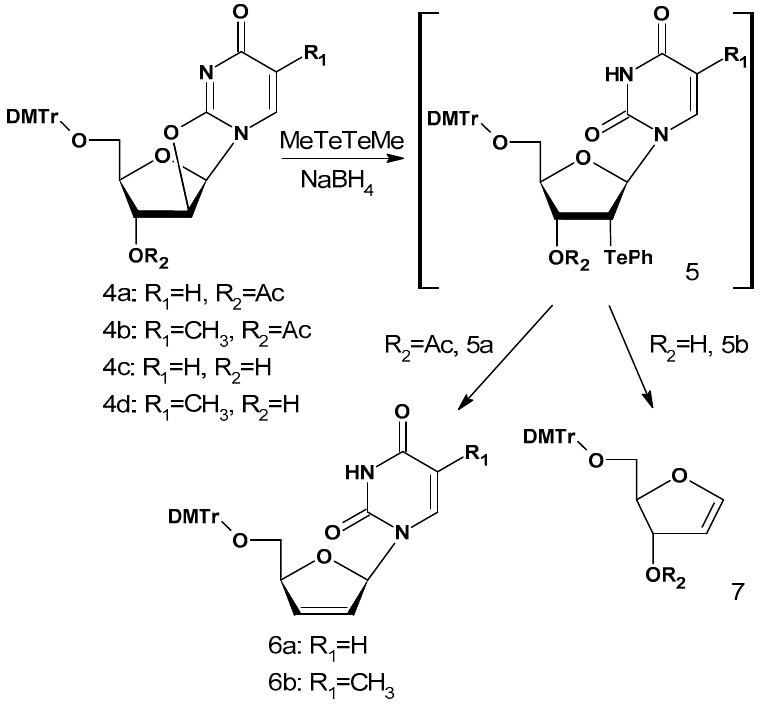
Scheme 4. Redox and fragmentation of Te-DNA